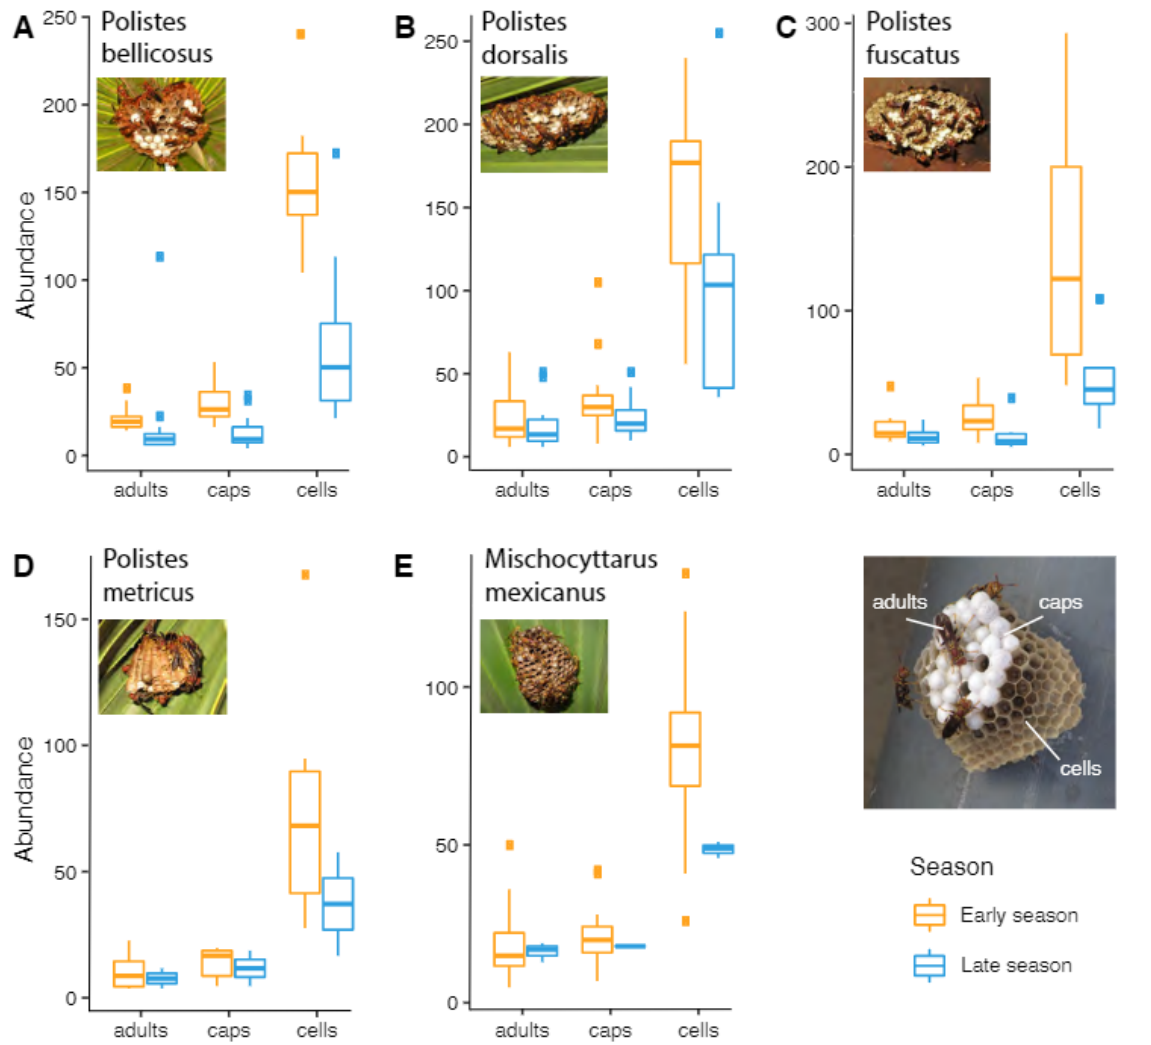
Figure 4. Peak number of adults, pupal caps, and cells in early and late season nests of each of five polistine species: Polistes bellicosus ( A ), P. dorsalis ( B ), P. fuscatus ( C ), P. metricus ( D ) and Mischocyttarus mexicanus ( E ).